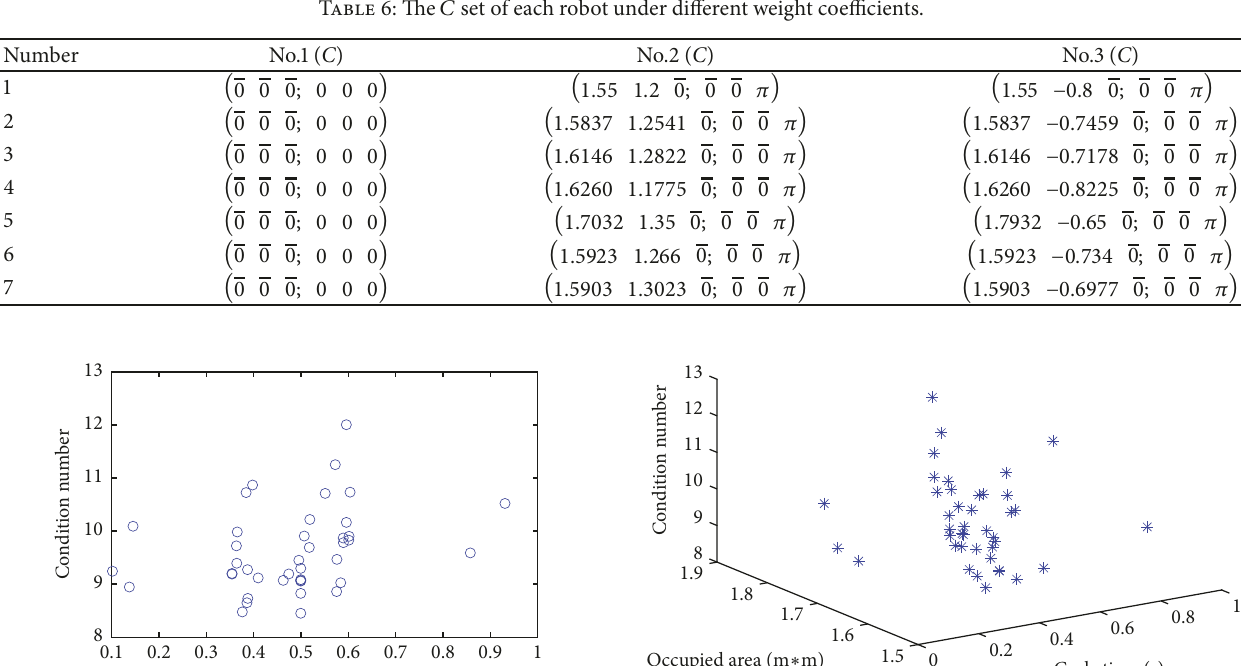
Table 6: The 𝐶 set of each robot under different weight coefficients.